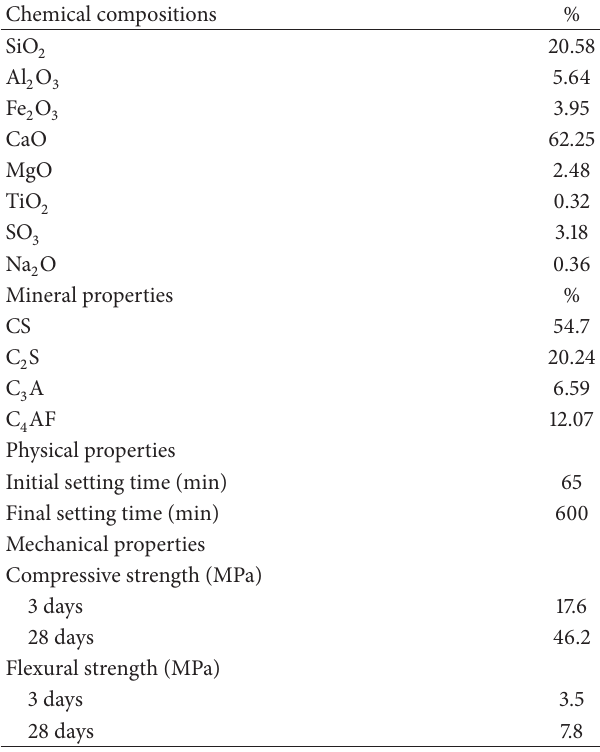
Table 1: The chemical compositions and physical properties of the OPC.